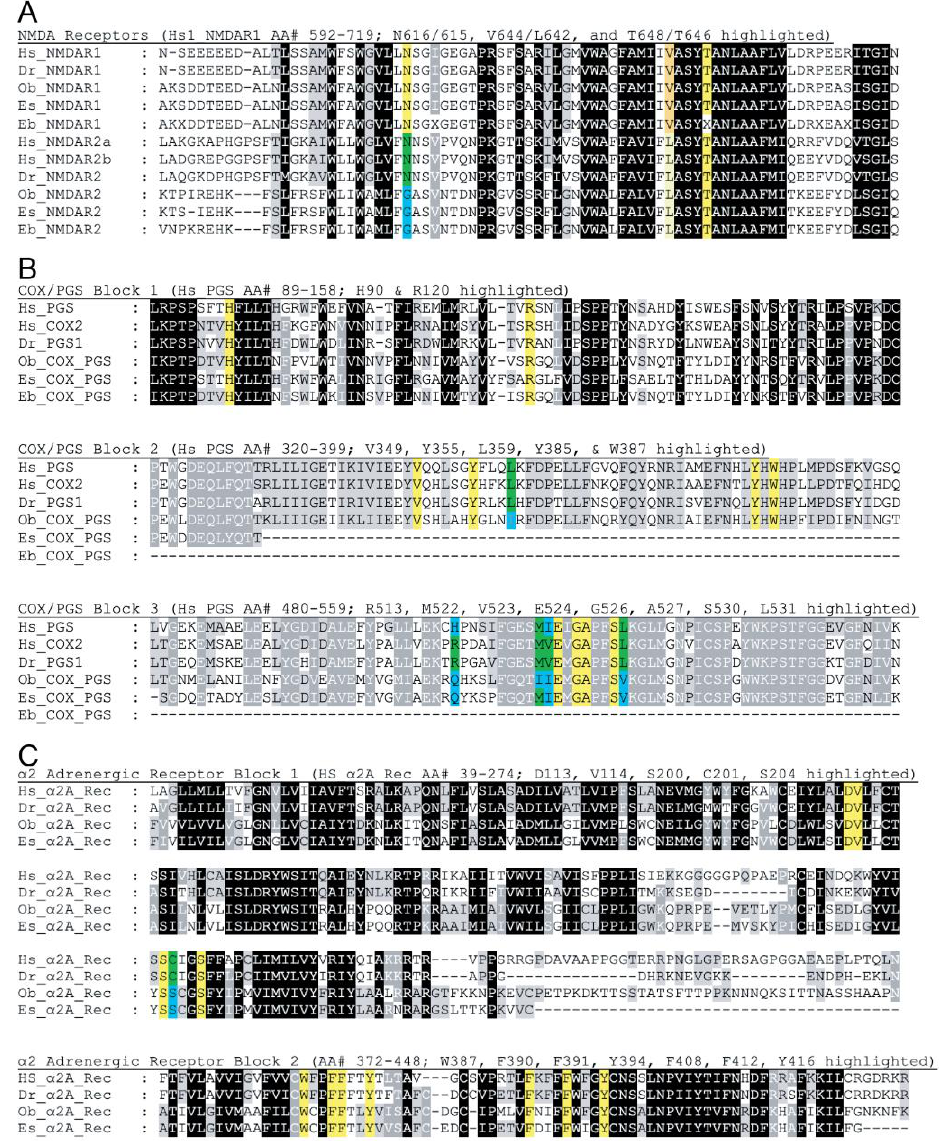
Figure 5. Multiple sequence alignments of putative receptors for Ketamine ( A ), Ketorolac ( B ), and Dexmedetomidine ( C ). Residues with described functions in vertebrates are highlighted in yellow if they are conserved in cephalopod sequences or highlighted in blue and green if they diverge. ( A ) Homologs for NMDAR receptors 1 and 2 are conserved across mammals and cephalopod species. Some residues surrounding the central vestibule containing the ketamine binding pocket [41] of NMDAR 1 (Hs_NMDAR1 T648-dark yellow, V644-dark yellow) and NMDAR 2 (Hs_NMDAR2 T646-bright yellow, L642-pale yellow) are conserved across species for which we have sequence data (Eb_NMDAR1 sequence quality was too low to confirm conservation of T648). NMDAR 1 exhibits conservation of N616 (bright yellow), but the conservation of the homologous site (N615) in NMDAR 2 was limited to vertebrates ( H. sapiens and D. rerio ), with a cephalopod glycine (bright blue) replacing the vertebrate asparagine (bright green). ( B ) The amino acid sequences for cephalopod cyclooxygenase-2/prostaglandin synthase (COX/PGS) are conserved with those of vertebrates ( H. sapiens and D. rerio ). Amino acid residues that line the cyclooxygenase channel in H. sapiens prostaglandin synthase (H90, R120, Y355, Y387, R513, E524, S530, and L531) or make contact with the NSAID Ibuprofen [42] (V359, L359, M522, V523, G526, and A527) were assessed for conservation. Complete conservation across cephalopods for which sequences were available) and verte- brates was observed in ten of these fifteen residues (bright yellow), while L359, R513, M522, V523, and L531 were not conserved in all cephalopods (bright blue and green residues). ( C ) The amino acid sequences for cephalopod (Ob and Es) alpha 2 Adrenergic (α2A) receptors are highly conserved with those of vertebrates (Hs and Dr). Amino acid residues known to line the binding pocket and